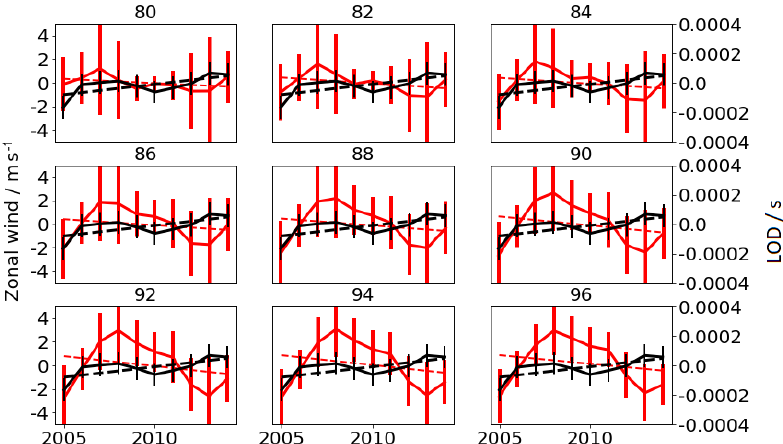
Figure 10. Same as Fig. 9, but for